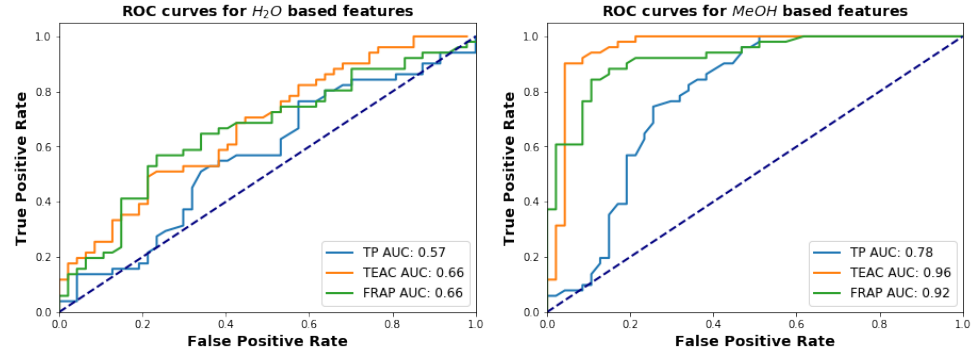
Figure 10. ROC curves for the three assays, for water ( left ) and methanol ( right ) extracts.